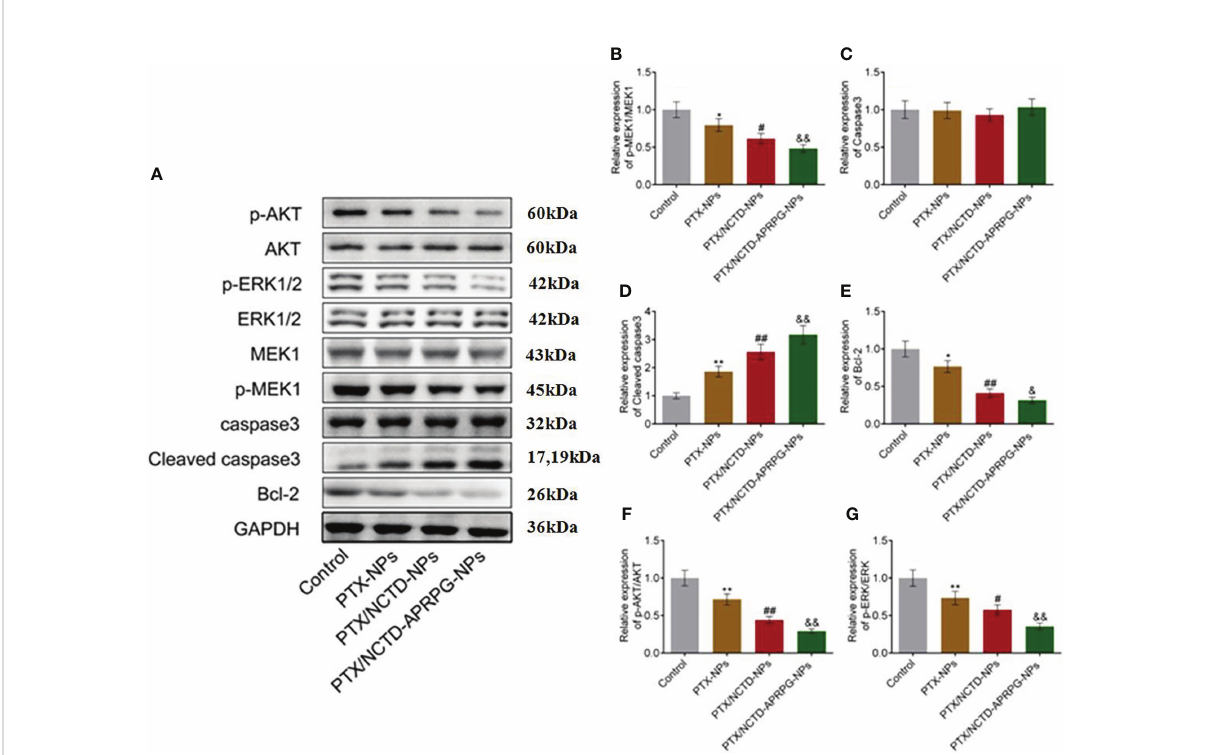
FIGURE 6 Effects of PTX-NPs, PTX/NCTD-NPs, and PTX/NCTD-APRPG-NPs on the AKT and ERK signal pathways in HepG2 cells. Western blot analysis was performed on AKT and ERK pathway protein expression in HepG2 cells treated with PTX-NPs, PTX/NCTD-NPs, and PTX/NCTD-APRPG-NPs. (A) Western blot images; (B) quantitative analysis of relative expression of p-MEK1/MEK1; (C) relative expression of caspase-3; (D) relative expression of cleaved caspase-3; (E) relative expression of Bcl-2; (F) relative expression of pAKT/AKT; and (G) relative expression of p-ERK/ERK. * p < 0.05 vs. control, ** p < 0.01 vs. control, # p < 0.05 vs. PTX-NPs, ## p < 0.01 vs. PTX-NPs, & p < 0.05 vs. PTX/NCTD-NPs, && p < 0.01 vs.